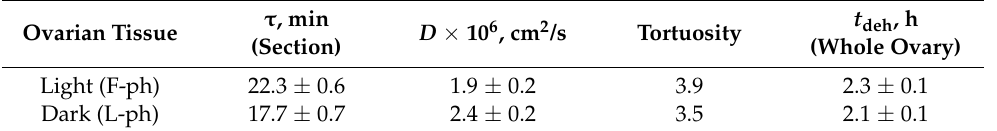
Table 1. Kinetic parameters of molecular diffusion in the sections of cat ovaries of the initial thickness l = 0.8 ± 0.1 mm and whole ovary (dehydration time t deh calculated using diffusion coefficient) at the application of 99.5% glycerol. Ovarian